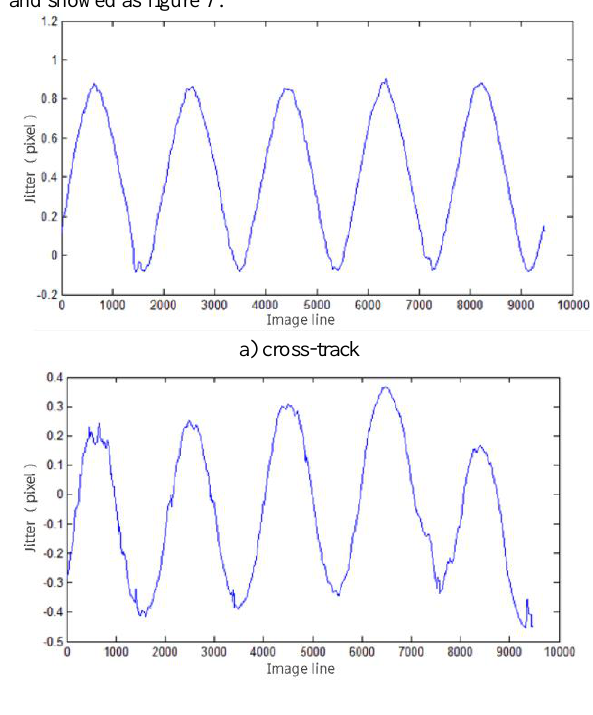
Figure 7. Parallax